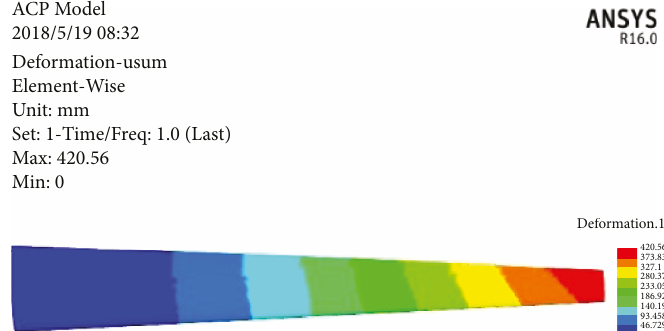
Figure 7: Deformation cloud diagram with the thickness of the skin being 12 mm.